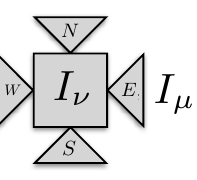
Figure 1. Illustration of the Maltese cross example. In this case τ = E and so G µ = G E G ν .